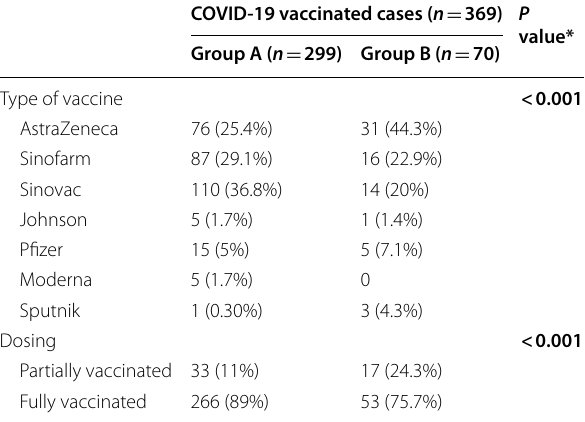
Data expressed as frequency (percentage). Only significant values should be in boldface ( P value was considered significant if < 0.05). COVID-19 coronavirus disease-19 * All data were compared with Chi 2